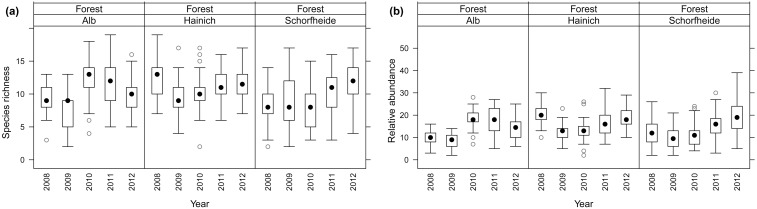
Temporal variation in the bird communities across five consecutive years (2008–2012) in the three study regions.(a) Temporal variation in species richness (counted bird species), and (b) temporal variation in relative abundance. The Black dot represents the median, the Box 1st and 3rd quartile, whiskers 95% confidence intervals and grey circles outliers.